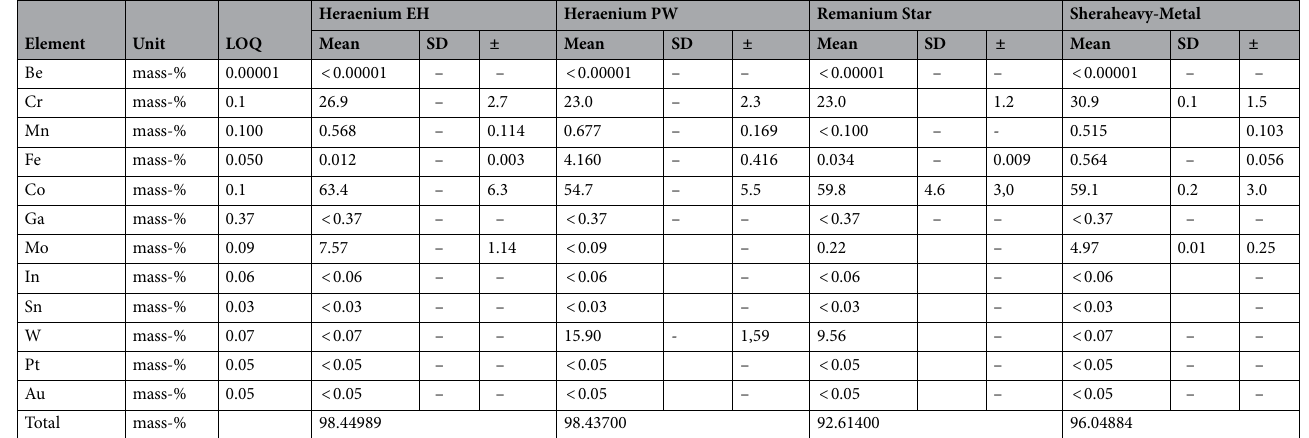
Table 4. ICP-OES results of non-precious metal alloys. LOQ limit of quantitation, SD standard deviation, ± : measurement